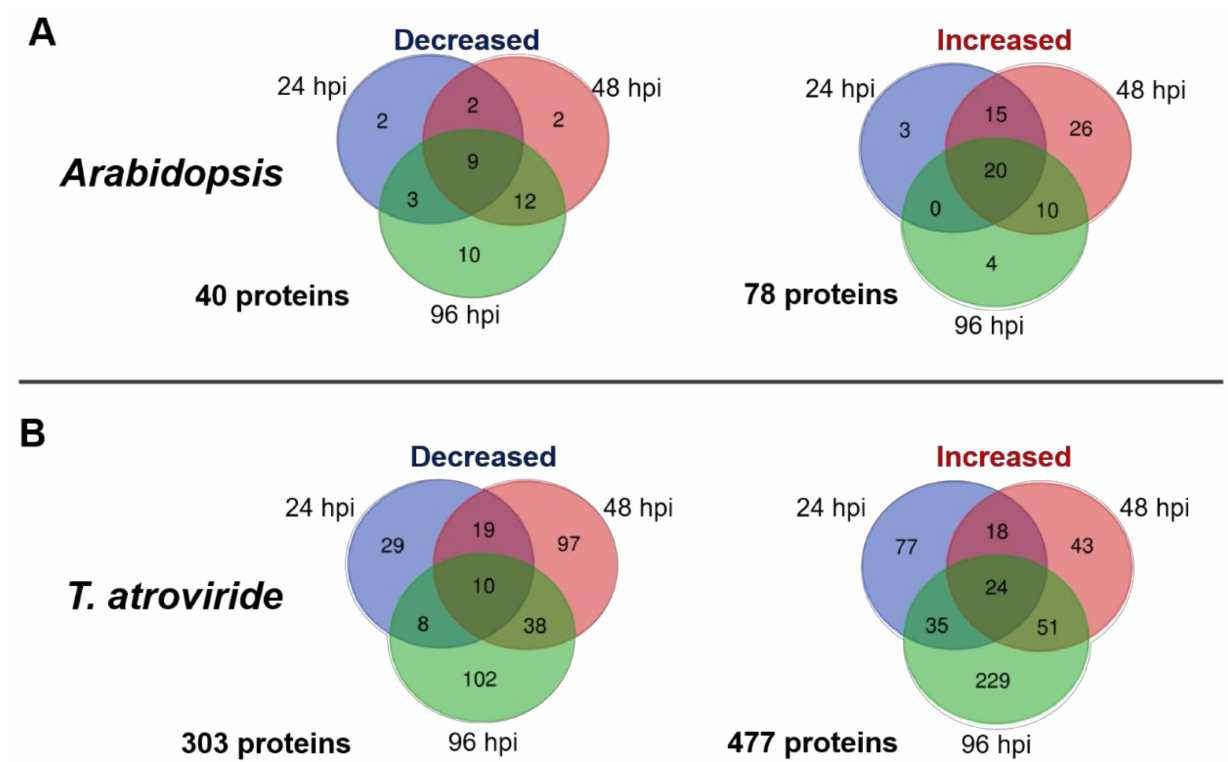
Figure 2. Venn diagrams showing the distribution of decreased and increased proteins at 24, 48, and 96 h of interaction. ( A ) Arabidopsis secretome. ( B ) T. atroviride secretome. Venn diagrams were constructed using the BEG tool (http:// bioinformatics.psb.ugent.be/webtools/Venn/, accessed on 2 August 2020). The total number of differentially expressed proteins is depicted to the left and belove of each